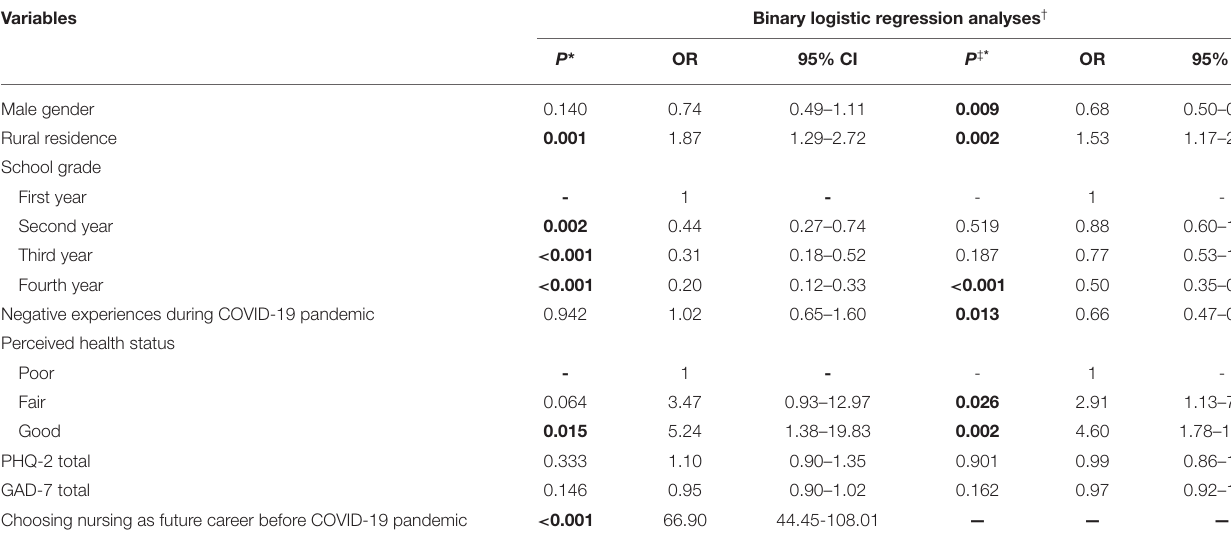
TABLE 2 | Independent correlates of choosing nursing as future career after the COVID-19 pandemic (binary logistic regression analyses). Variables Binary logistic regression analyses